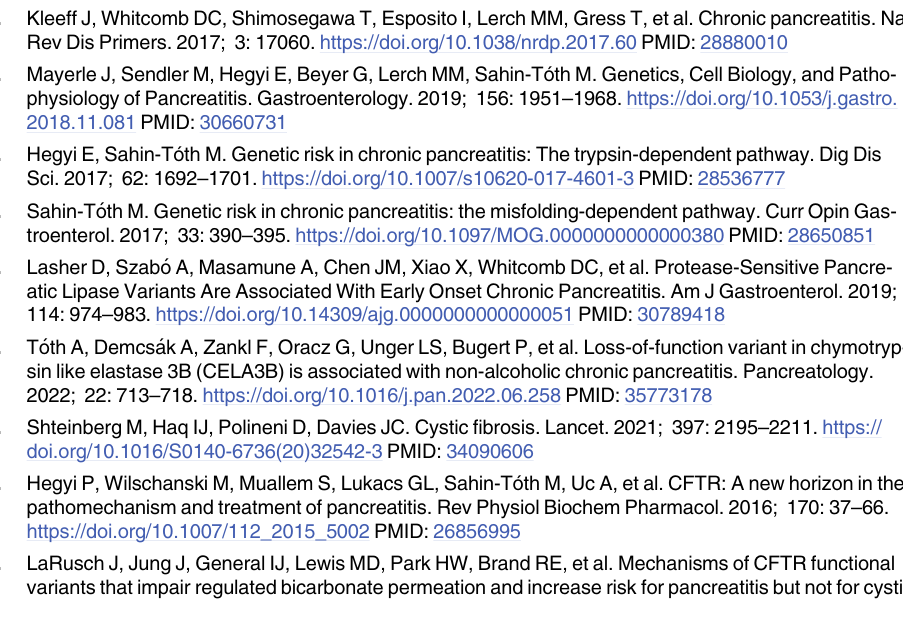
S1 Table. Newcastle-Ottawa Scale (NOS) for quality assessment of the case-control studies selected for meta-analysis. S2 Table. Characteristics of studies included in the meta-analysis. S3 Table. Allele frequency of CFTR BD variants in studies included in the